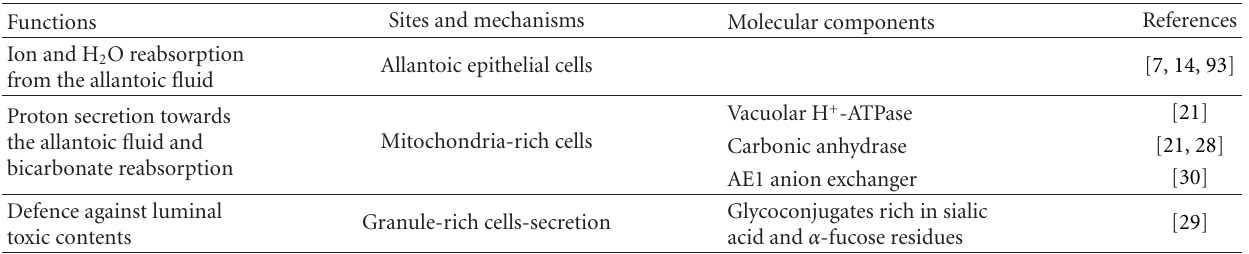
Table 2: A schematic view of the functional roles of the allantoic